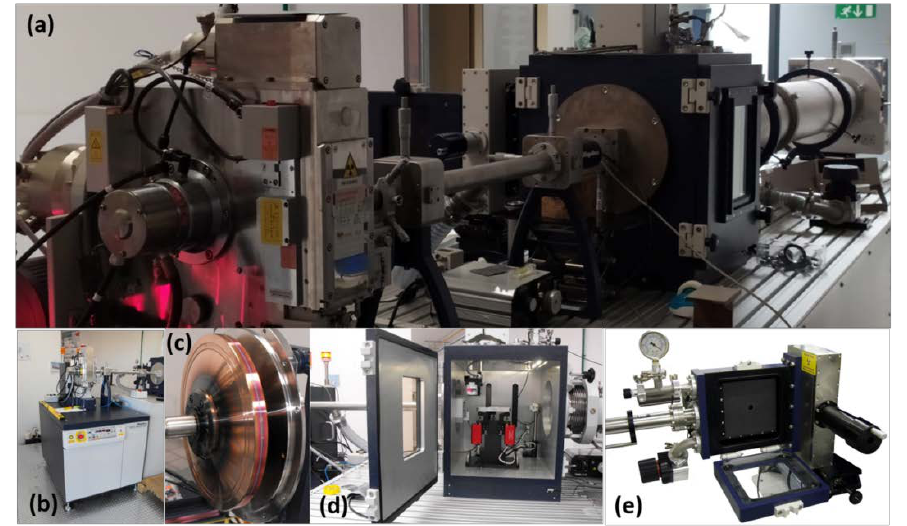
Figure 2. ( a ) X-ray MicroImaging Laboratory (XMI-L@b) set-up; in details: ( b ) Fr − E + SuperBright microsource; ( c ) Cu rotating anode; ( d ) the sample chamber; ( e ) load-lock system for mounting / demounting the image plate detector for wide-angle X-ray scattering (WAXS) / grazing incidence wide-angle scattering (GIWAXS) data collection.